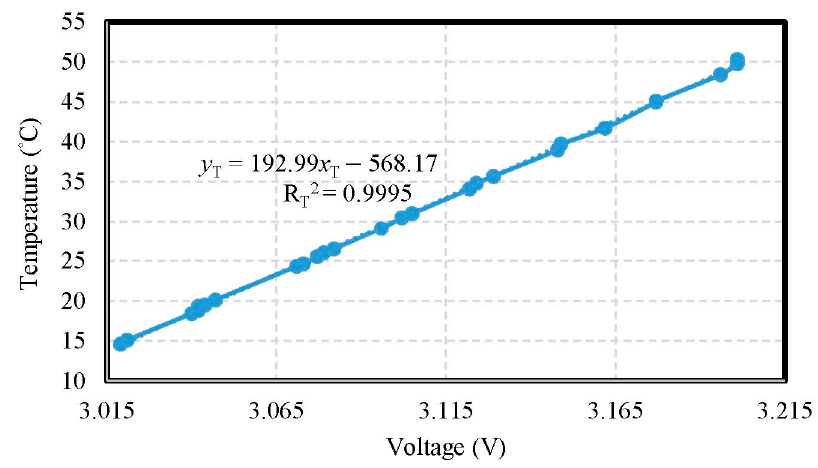
Figure 5. The calibration curve of the temperature.